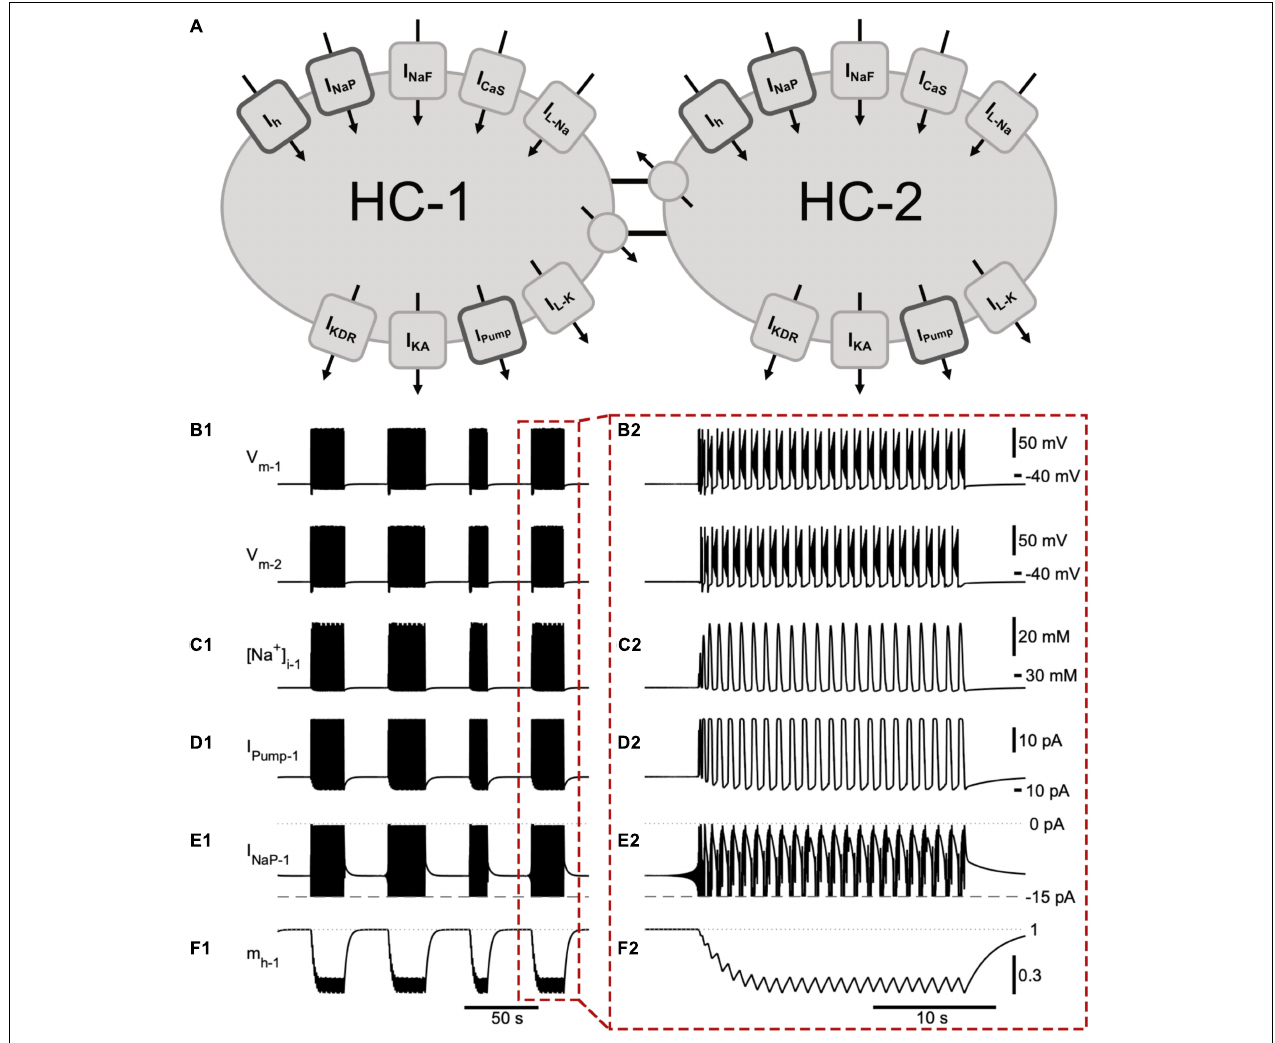
FIGURE 1 | A half -center oscillator model produces episodic bursting activity. (A) Schematic representation of the model showing all membrane currents for the two mutually inhibitory cells of the half-center oscillator (HCO). Inward currents include the slow calcium current ( I CaS ), fast Na + current ( I NaF ), persistent Na + current ( I NaP ), Na + leak current ( I L − Na ), and a hyperpolarization-activated cation current ( I h ). Outward currents are the potassium leak current ( I L − K ), delayed rectifier potassium current (